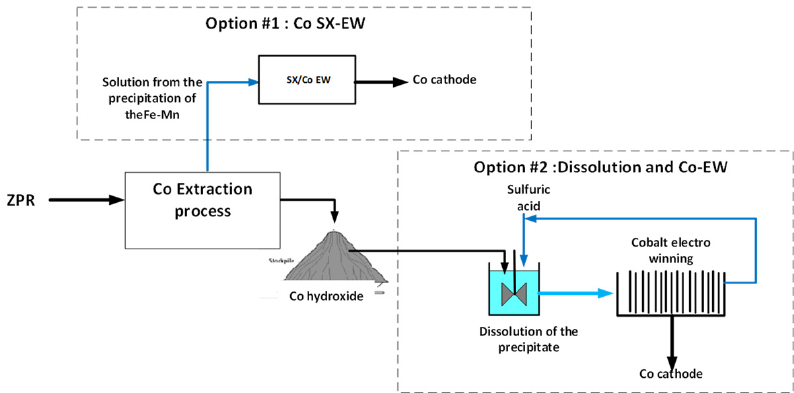
Figure 11. Processing options to produce electrolytic cobalt.